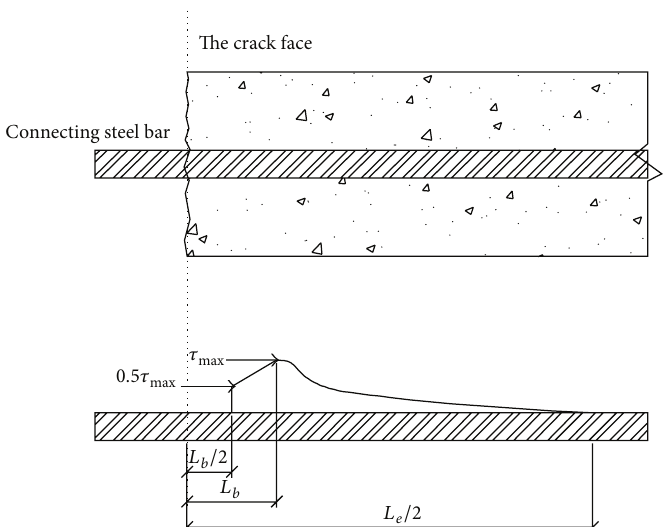
Figure 2: The bond shear stress distribution on connecting steel bar surface under gap opening